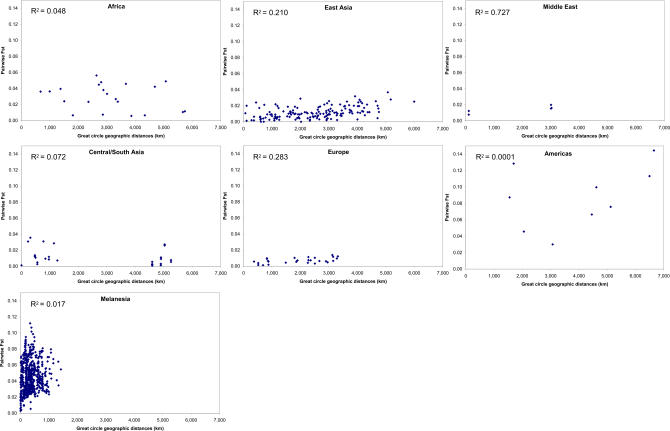
Genetic versus Geographic Distances within ContinentsRegional correlations between F
ST and geographic distance for population pairs.